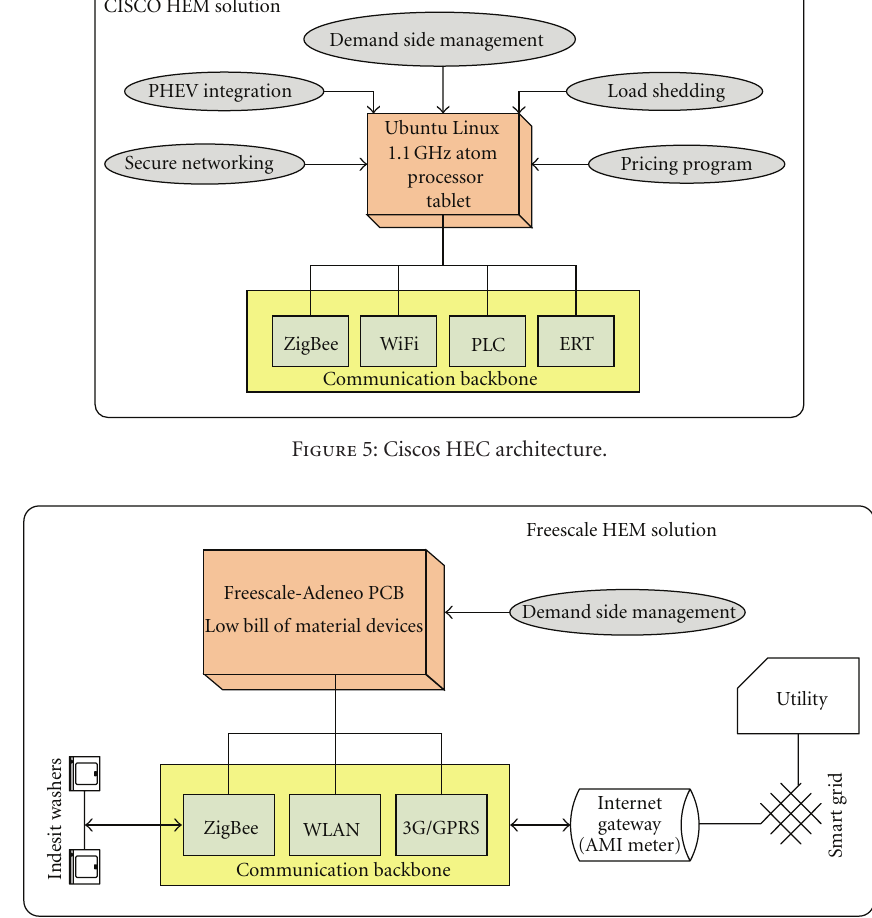
Figure 6: Freescale Technology for a home energy